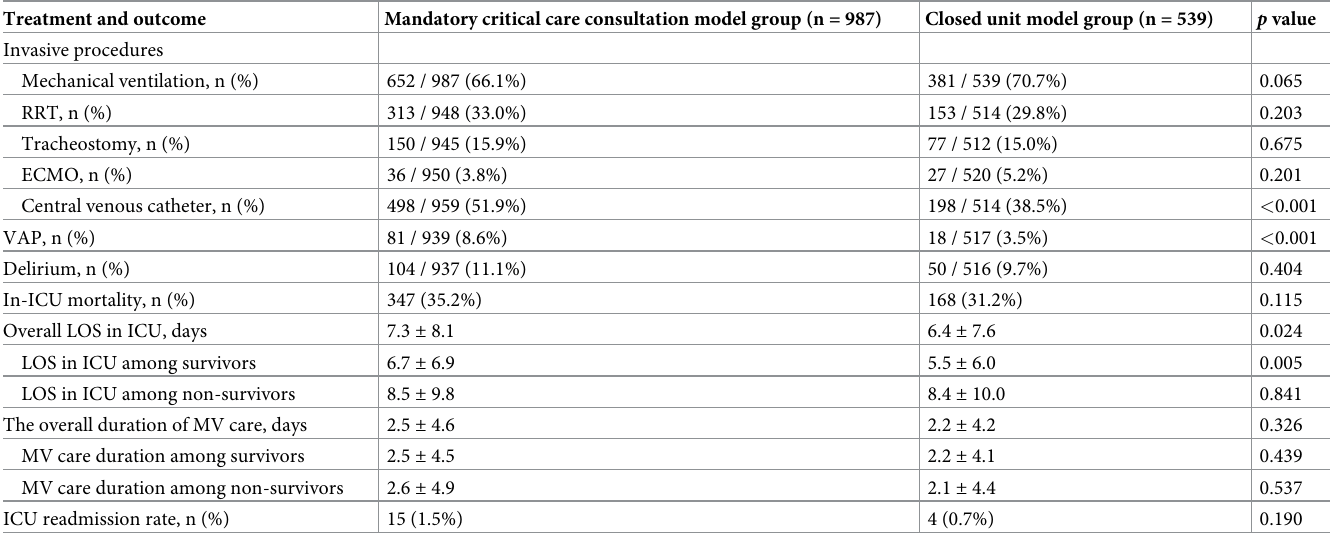
Table 2. The study participants’ treatments and clinical